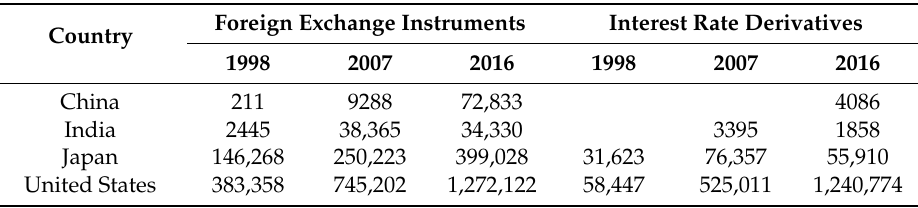
Source: (Bank for International Settlements